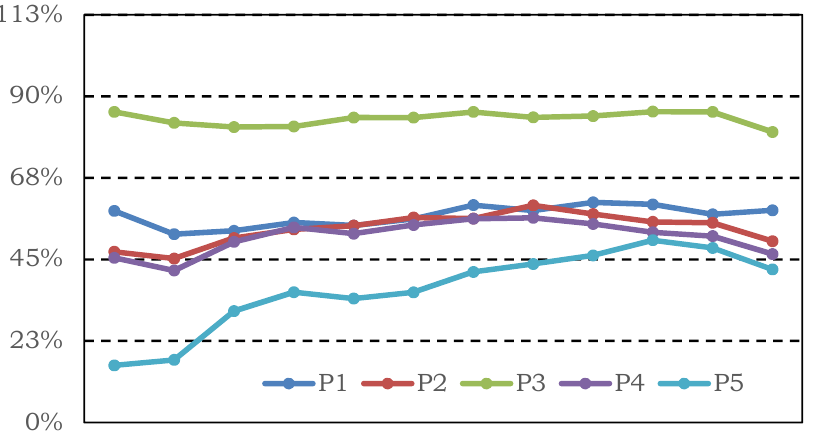
Figure 3. Annual transitions of the averages of dummy variables P1 to P5 of Company